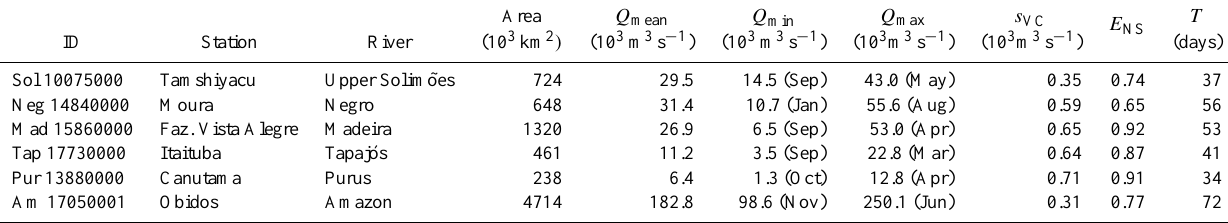
Table 1. Gauging stations from Fig. 1a with summary of discharge regime, MGB-IPH model skill and results. Area Q mean Q min Q